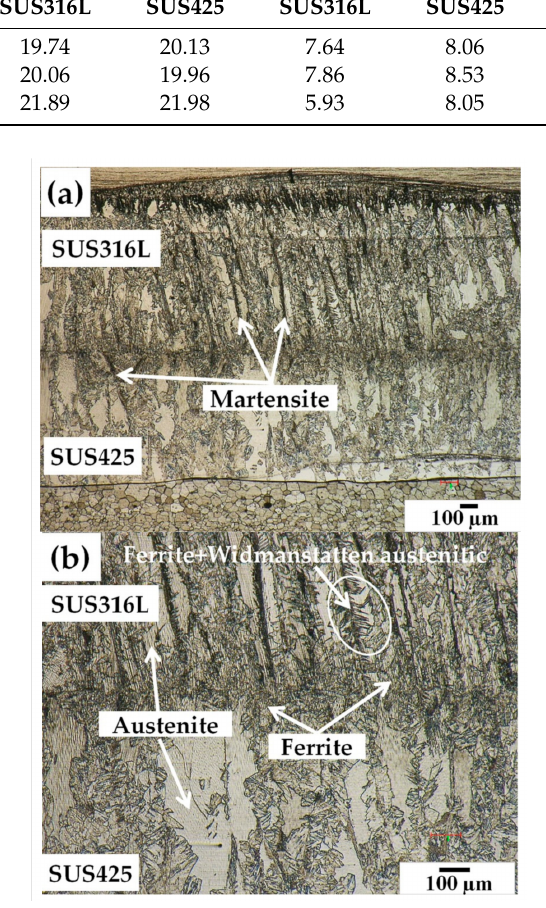
Table 8. Cr and Ni equivalents and ratios of area C (the FZ of SUS316L and SUS425). Weld Current (kA)